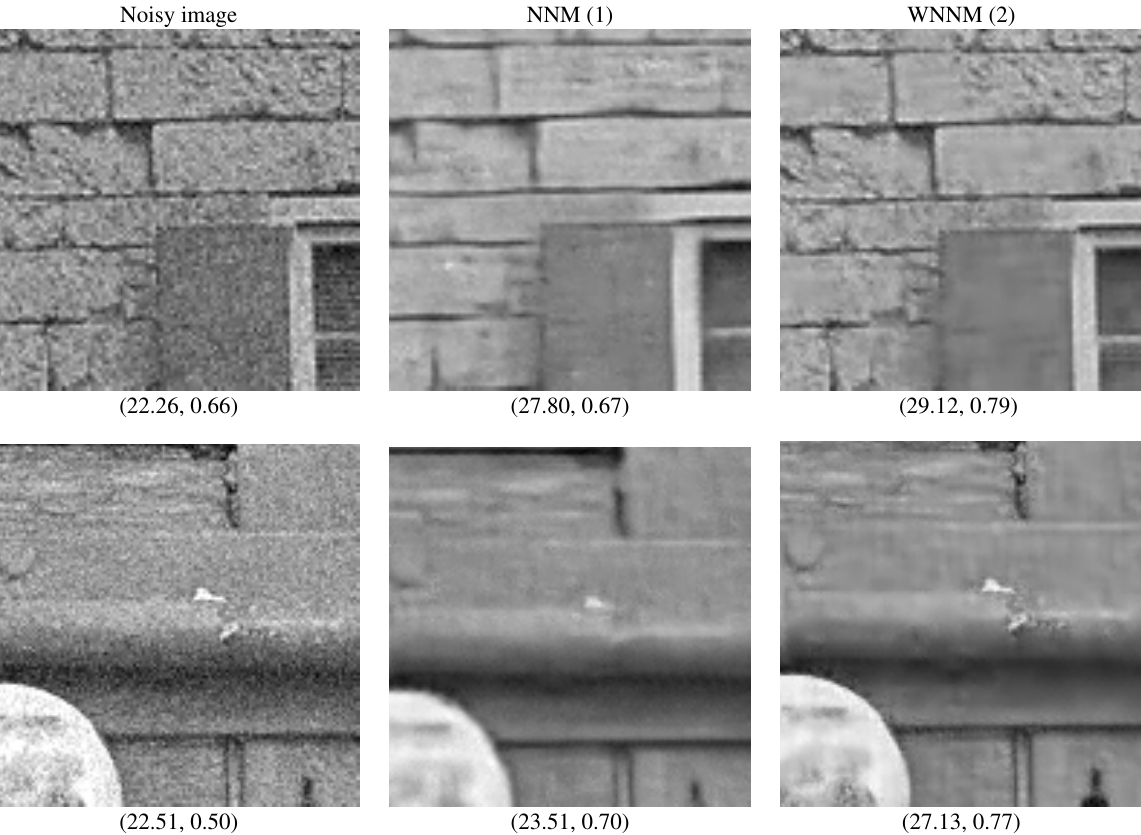
Figure 1. Image denoising using minimization of nuclear norm (1) and weighted nuclear norm (2). The values of (PSNR, SSIM) and shown, higher values are